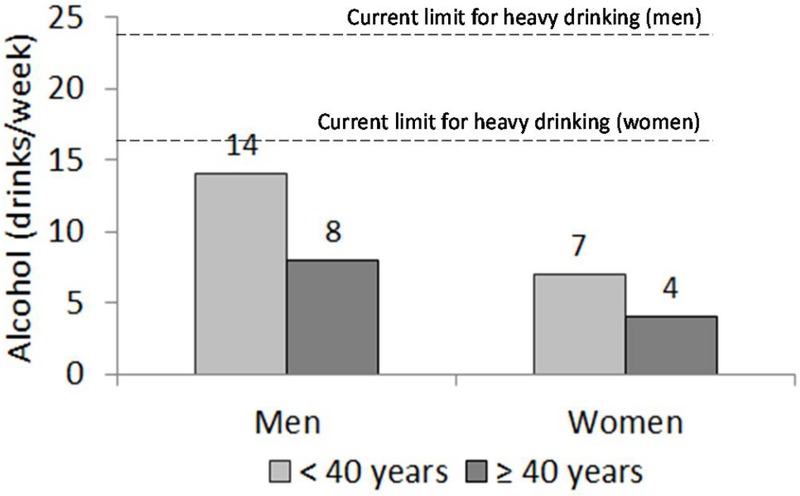
Estimated threshold doses of alcohol consumption (standard drinks /week) for initiating a significant GGT activation.The levels leading to GGT increases especially in those above 40 years of age are markedly lower than the current limits of heavy drinking in many Western countries (men: 24 drinks, women: 16 drinks) (dashed line).